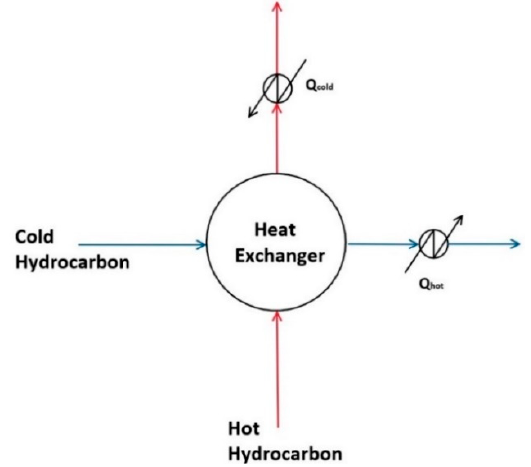
Figure 1. Heat exchanger system layout.